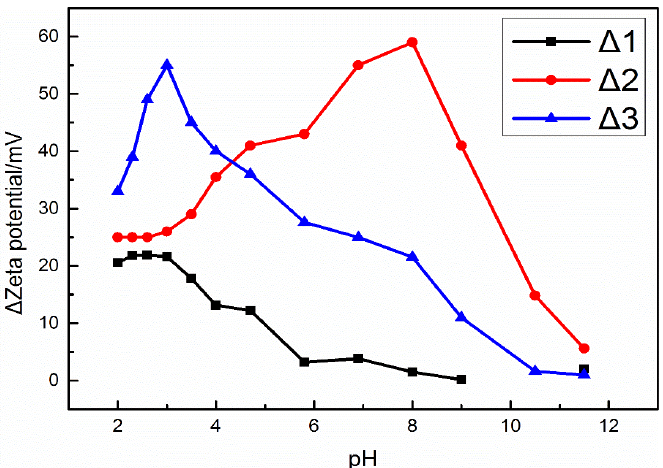
Figure 8. ∆ Zeta potential of rutile surface with a function of pH: ∆ 1 is the difference before and after SPA addition without activation ions; ∆ 2 is the difference before and after SPA addition with Pb 2+ ions; ∆ 3 is the difference before and after SPA addition with Bi 3+